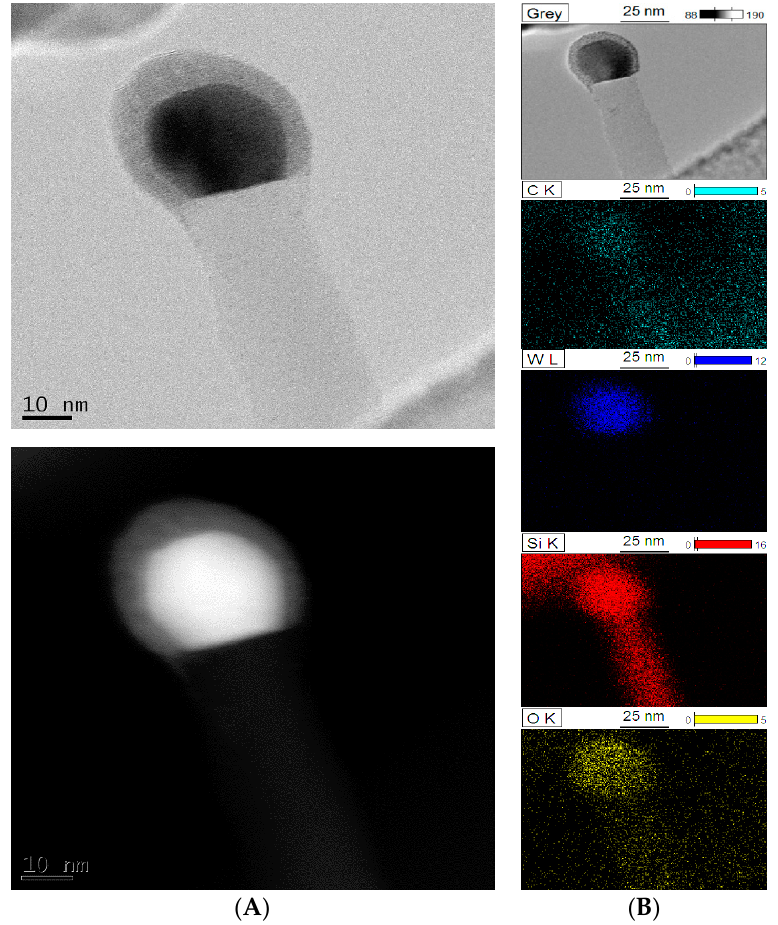
Figure 5. STEM images of a whisker in (10) W x C- β -SiC catalyst: ( A ) BF-STEM image and BF-STEM image with contrast; ( B ) BF-TEM image and EDS element maps of the whisker.